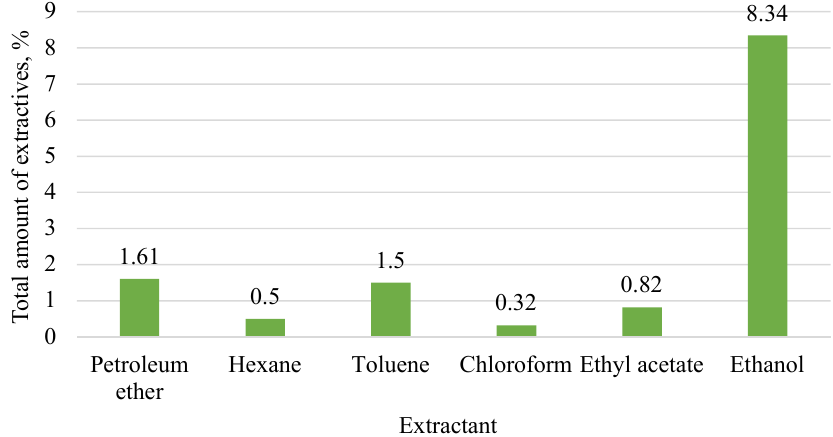
Fig. 4. Graphic dependence of the total amount of extractives in birch shoots on the extractant used